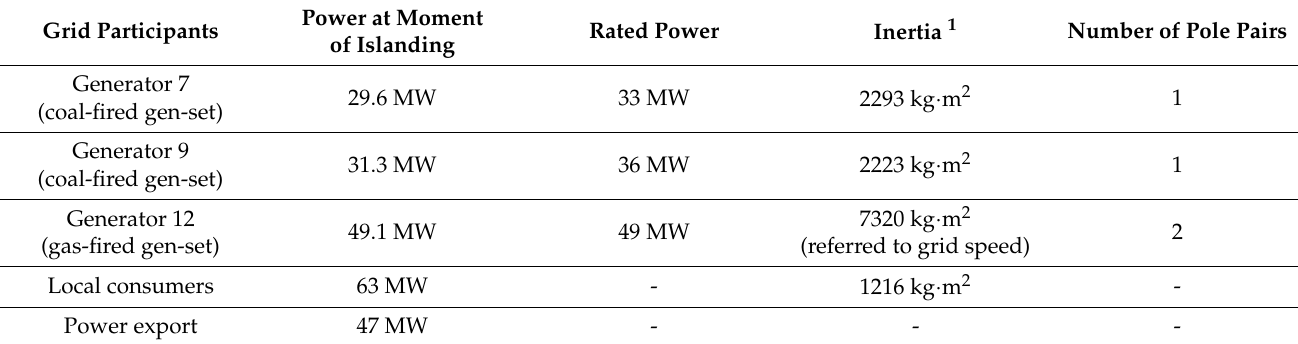
Table 1. Specifications and operating points of the generator and the local